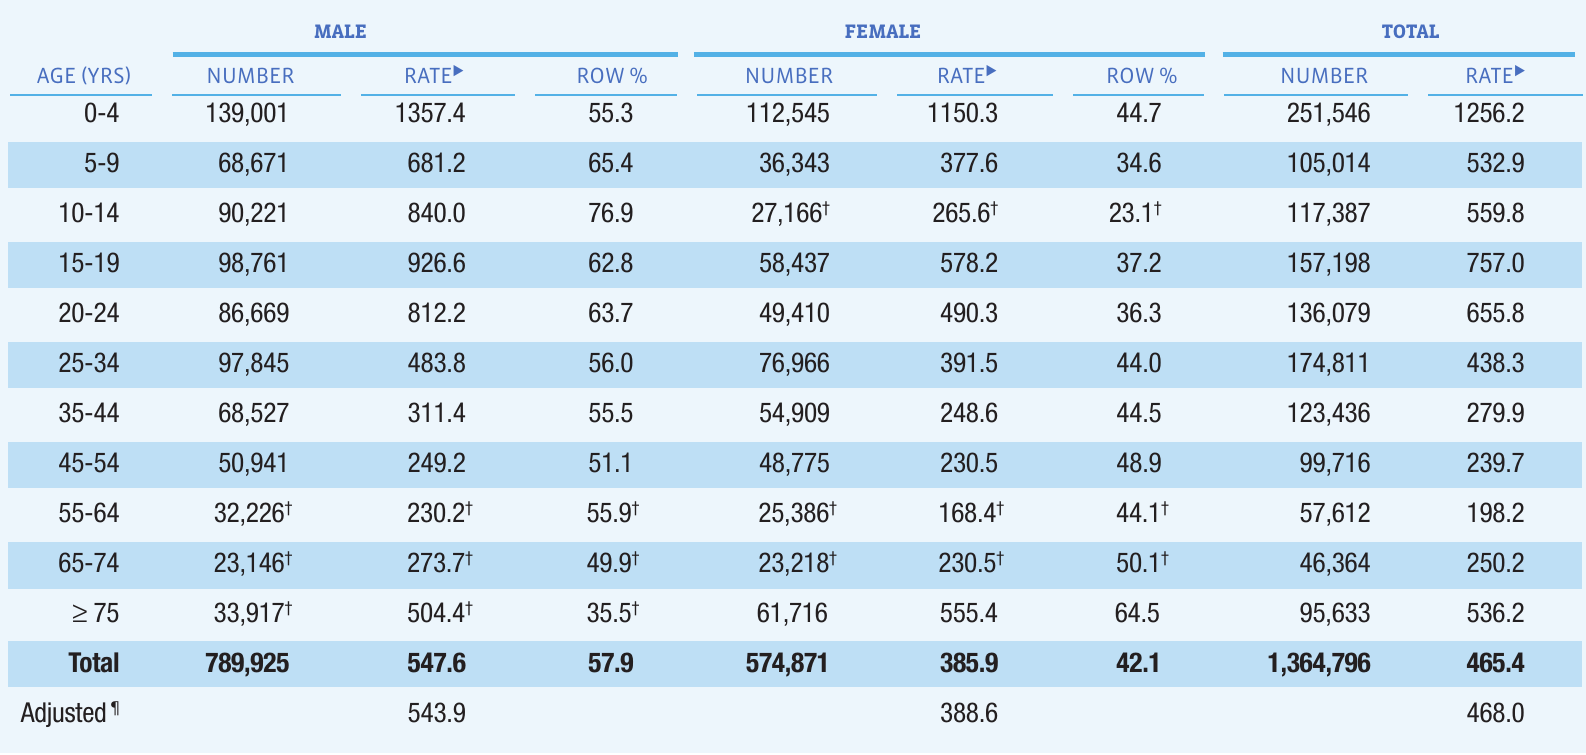
TABLE 3: Estimated Average Annual Numbers, Rates, and Percentages of Traumatic Brain Injury-Related Emergency Department Visits, by Age Group and Sex, United States,